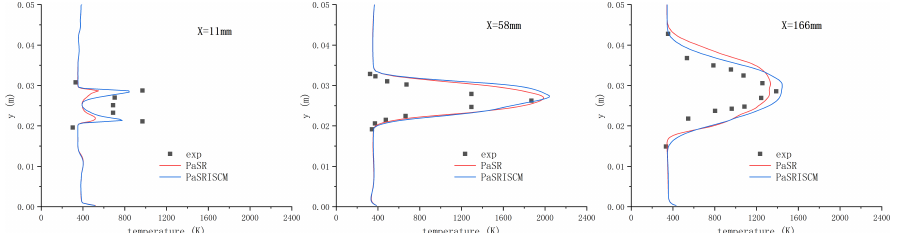
Figure 15. Averaged temperature profiles compared with experimental results at three locations using different combustion models.